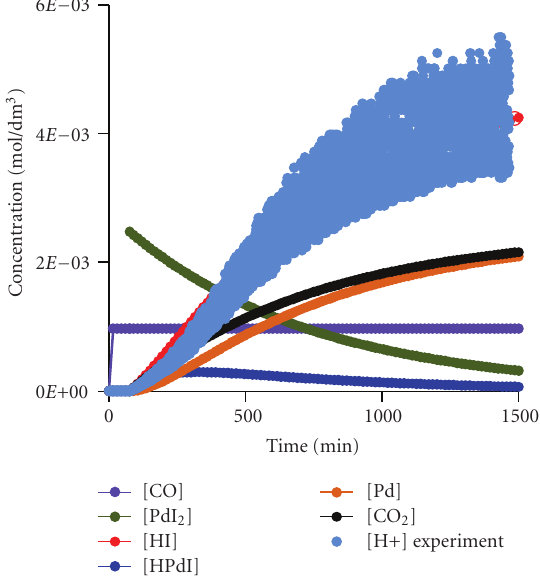
Figure 6: Fitted data using Model 1 against experimental data pre- sented in Figure